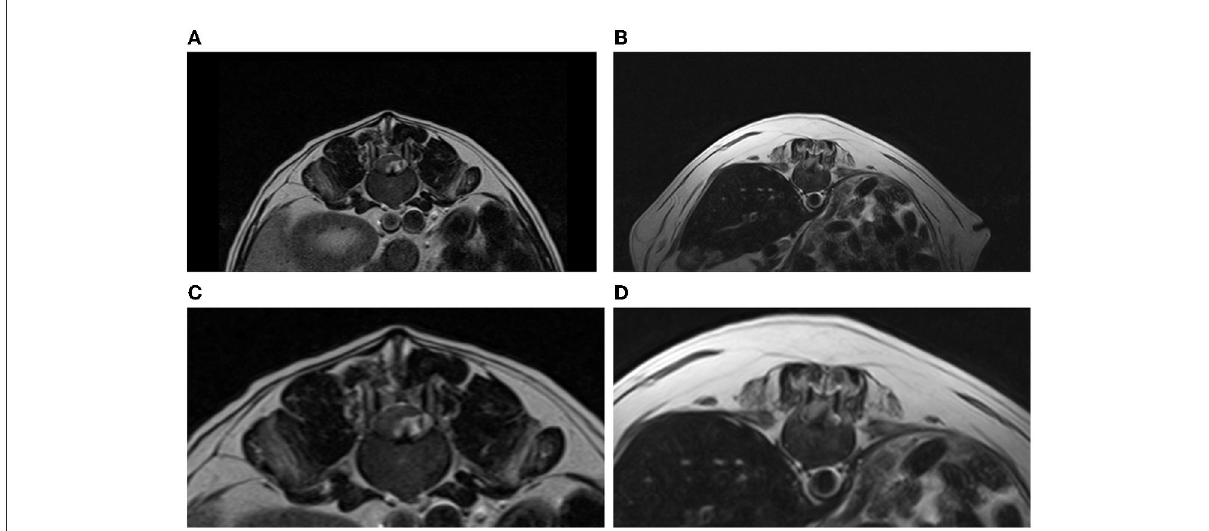
FIGURE2 (A,C) T2-weighted transverse sequence showing a L3-L4 intradural/extramedullary disc extrusion (Case 4). The T2-weighted homogeneous hypointense disc material is appreciated on the left side compressing moderately the spinal cord ventrally and to the right. This is appreciated as a beak-like shaped and sharply marginated lesion (“beak sign”). The T2-weighted hyperintense signal within the subarachnoid space representing CSF is appreciated surrounding the intradural disc material. (B,D) T2-weighted transverse sequence displaying a T11-T12 intradural/extramedullary disc extrusion with the presence of a “beak sign” (Case 3). This is appreciated as a sharply marginated T2-weighted hypointense lesion that is compressing the spinal cord to the right